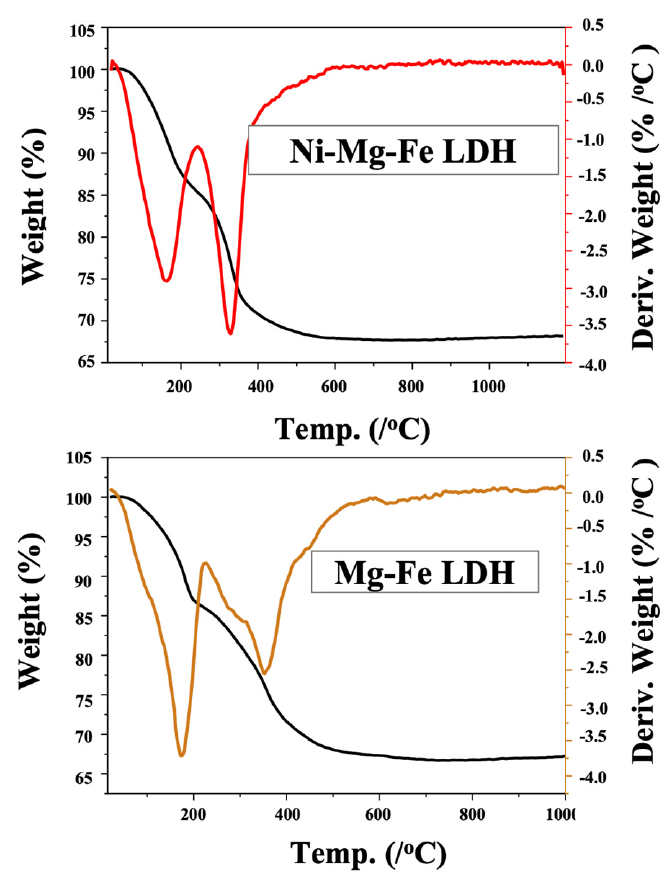
Figure 2. TGA and DTG thermograms of the Mg-Fe LDH and Ni-Mg-Fe LDH catalysts.